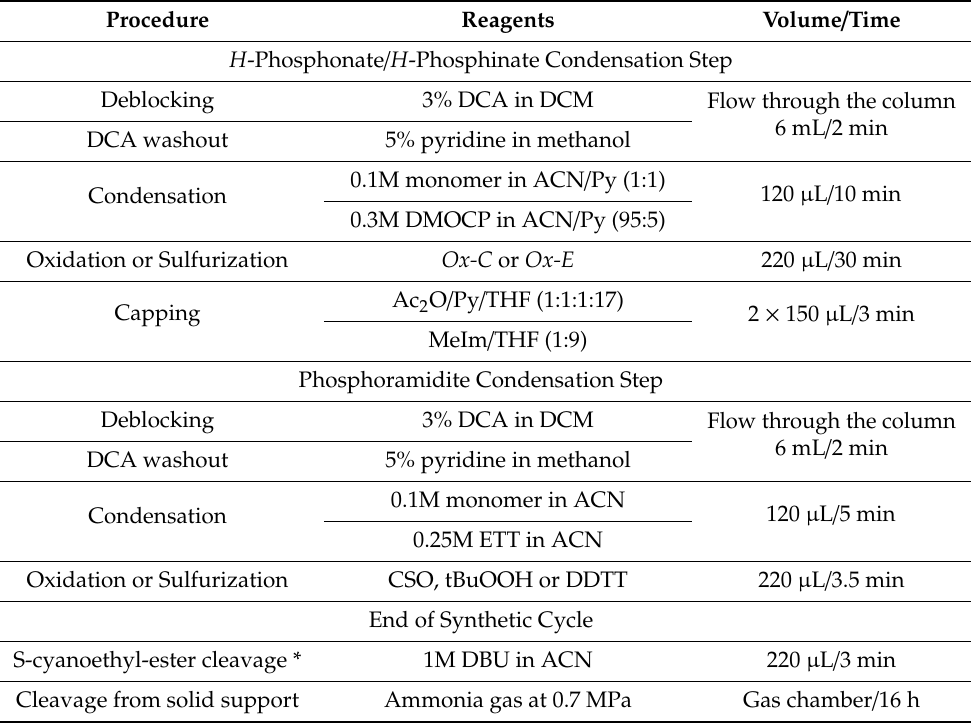
Table 5. Synthetic Protocol B (For more details see Supporting